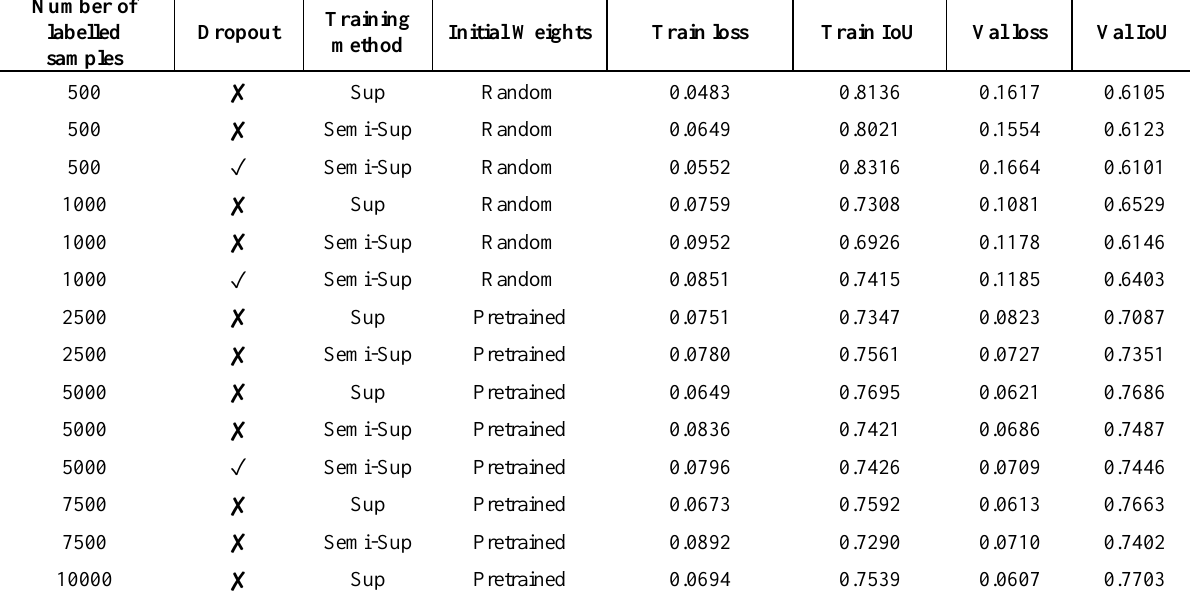
Table 1 . Training and validation IoU metrics for semi-supervised and supervised models for varying number of labelled training samples